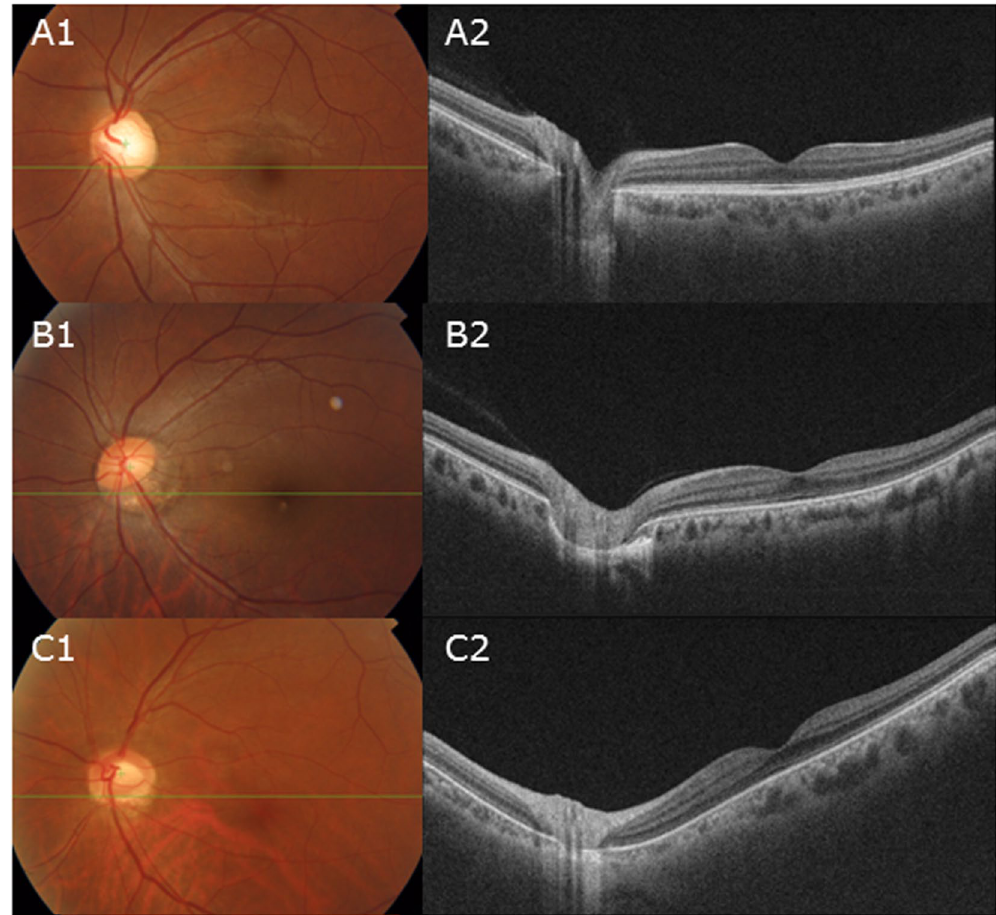
Figure 5. Representation showing the increasing disc torsion degree (section A1 to C1) increased the Fovea- Disc depth (section A2 to C2).